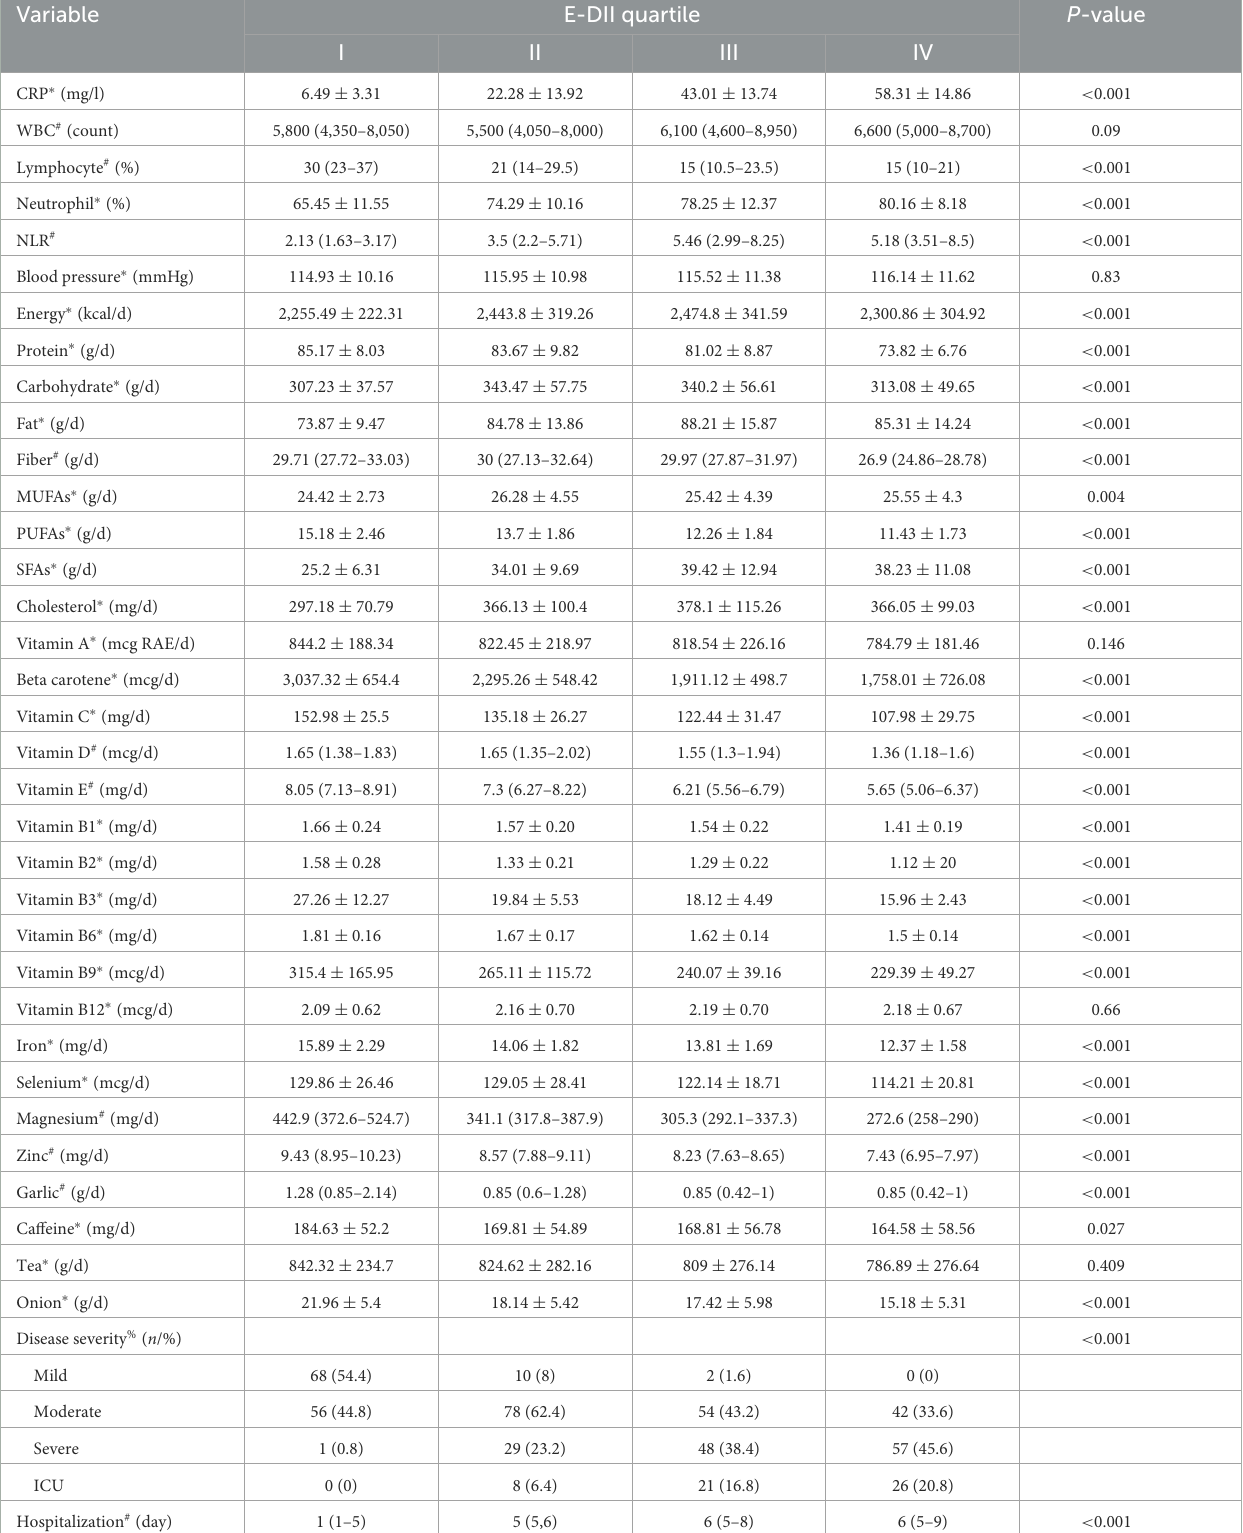
TABLE 3 Biochemical measures, dietary factors, and disease severity among the energy-adjusted dietary inflammatory index (E-DII) quartiles.